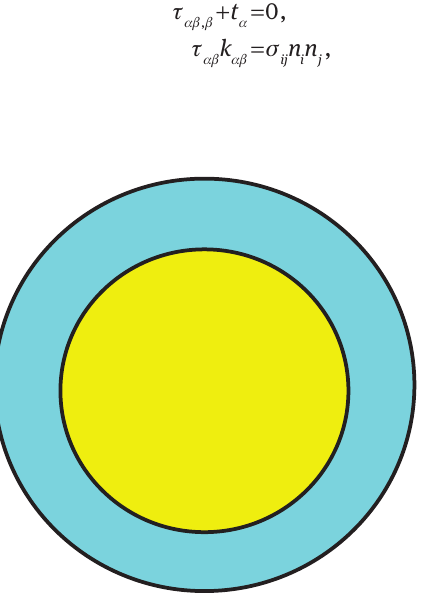
Figure 1 A nano-sphere with a surface